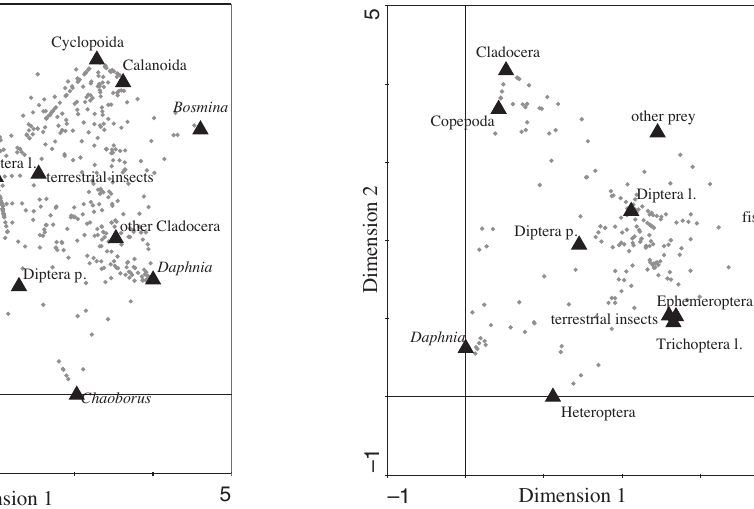
contents (proportion prey number) largemouth black bass, Micropterus salmoides in Monte Novo and Tapada Grande reservoirs, Iberian Peninsula: food cat- egory and sample (stomachs) scores for the first and second